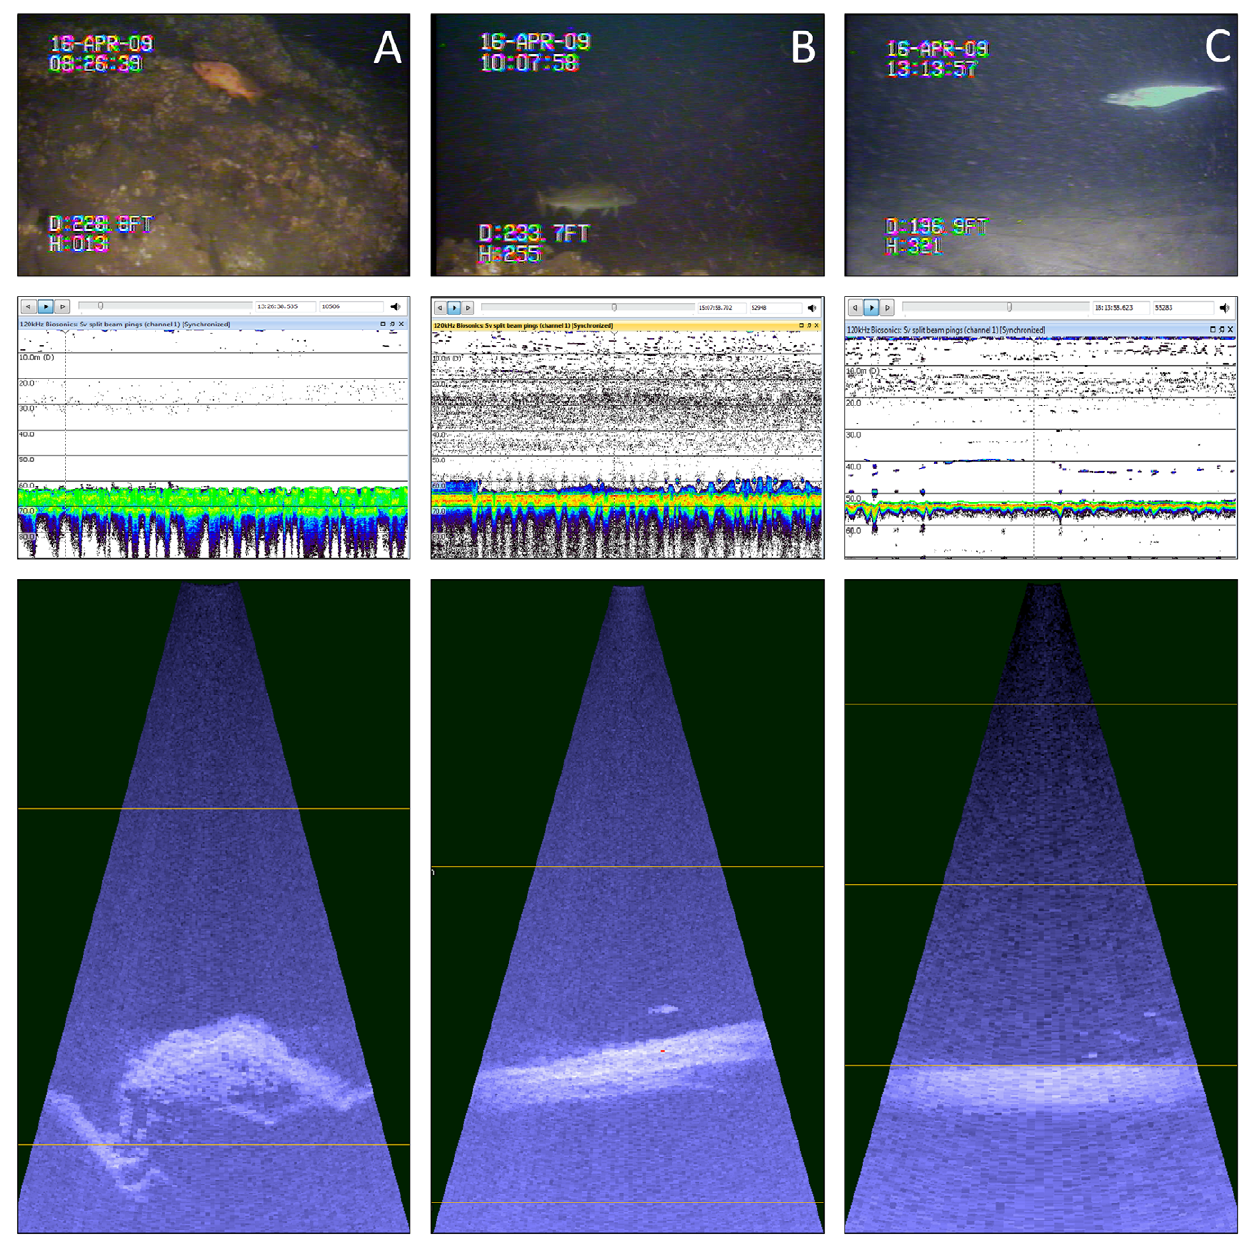
Figure 2. Example images collected from contemporaneously deployed ROV (top row), 120-kHz split beam echosounder (middle row), and DIDSON (bottom row) over boulder/lava field (a), transitional (b), and sand (c) designated habitats off southwest Iceland, 15–16 April 2009. Note redfish Sebastes sp. identified in ROV video data collected from boulder/lava field habitat, Atlantic cod Gadus morhua identified in both ROV and DIDSON data, and haddock Melanogrammus aeglefinus identified in the ROV data with faint targets detected near the substrate in the DIDSON and 120-kHz split beam echosounder data. doi:10.1371/journal.pone.0051321.g002 configuration, echograms were visually inspected for bad data When a fish was visible for several frames, its vertical speed (rate of regions (i.e., abnormal towfish behavior or loss of signal) and ascent or descent) was calculated. manually excluded. Data within 3 m of the transducer face were excluded to account for surface noise and nearfield effects. A bottom detection algorithm with a 0.5 m backstep [36] was applied to exclude the sea floor and boulder/lava field structure from the analysis, and then manually edited. Along-transect areal backscatter densities (s A t, m 2 nmi 2 2 ) [37] were classified by habitat type (sand ridges, sand with intermixed rocky bottom [transition